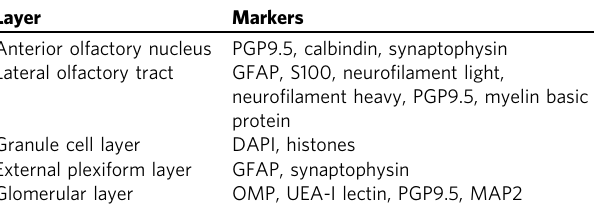
Table 1 Marker signatures for olfactory bulb